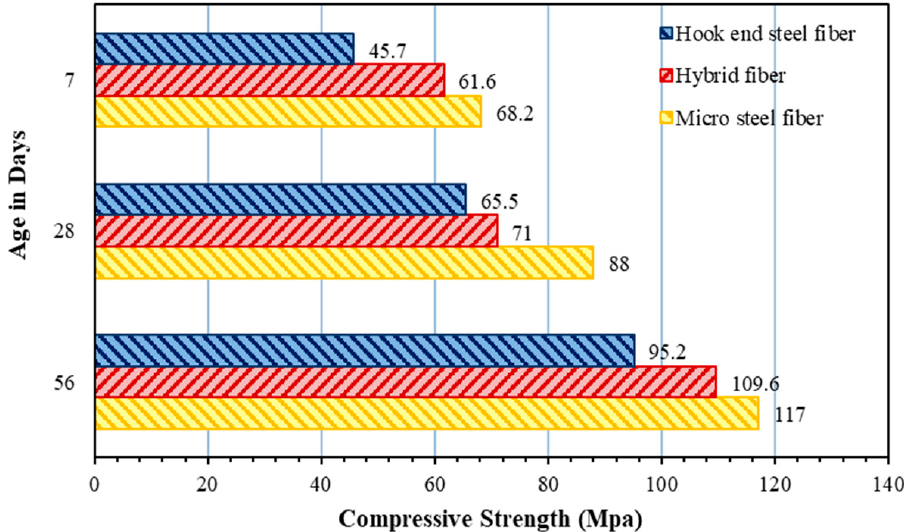
Figure 8. The compressive strength of the SIFCON using various types of fibres. The results revealed that micro-steel fibre has a significantly higher compressive strength than other fibre types (hooked end and hybrid). The increase in the compressive strength of samples of micro steel fibre is attributed to the higher aspect ratio of micro steel fibre compared to other types of fibres; the micro fibres are shorter than other types and thereby occupy a smaller area in the concrete, which in turn results in a significant increase in the number of fibres used in the concrete [18]. The results also showed that the SIFCON samples with hybrid fibres have better compressive strength than those with hooked fibres. This is because the hooked ends and micro steel fibres have combined effects in bridging the concrete matrix and reducing the cracks’